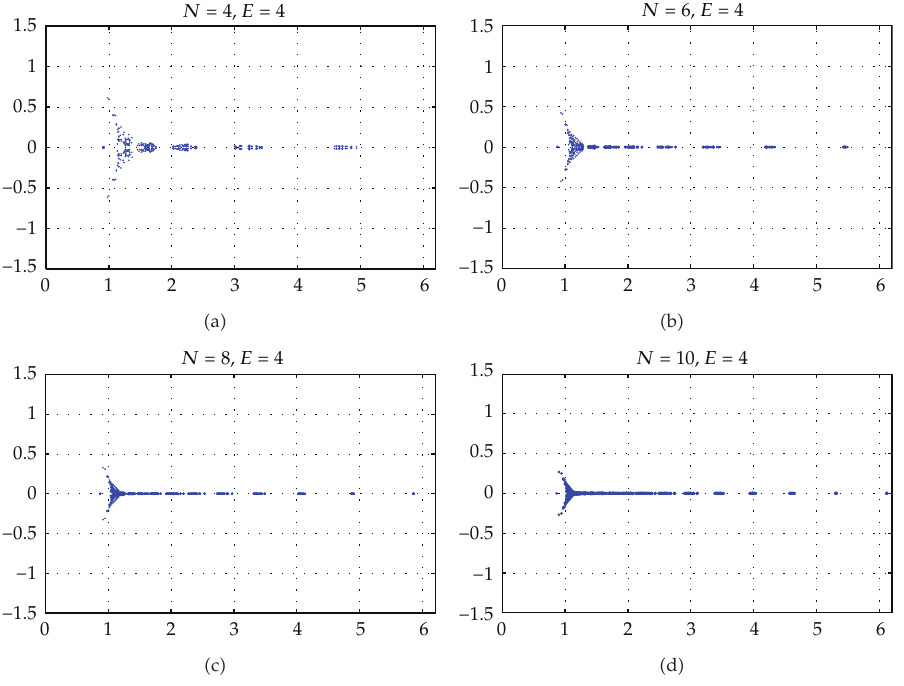
(cid:2) A (cid:2) B − 1 N (cid:2) 4 , 6 , 8 , 10 and E (cid:2) 4 when δ (cid:2) 1 , b (cid:2) (cid:5) 1 , 1 (cid:6) T N 2 for h 2